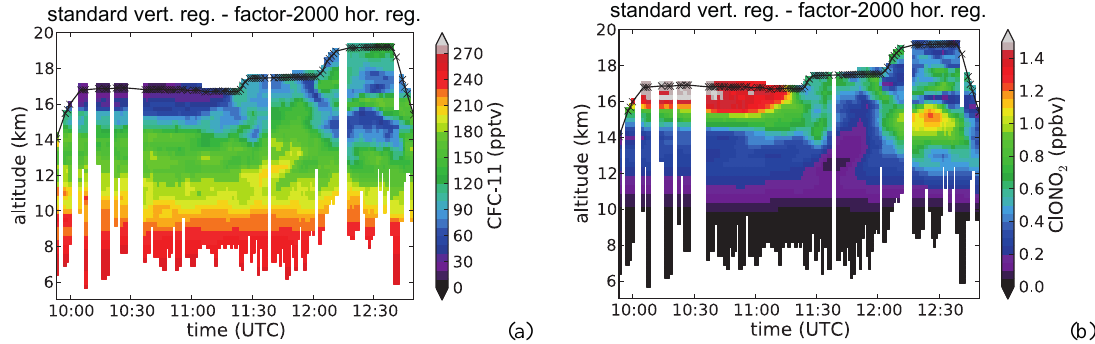
Fig. 4. Two cross-sections of CFC-11 (a) and ClONO 2 (b) volume mixing ratios with standard vertical regularisation and factor-2000 horizontal regularisation.